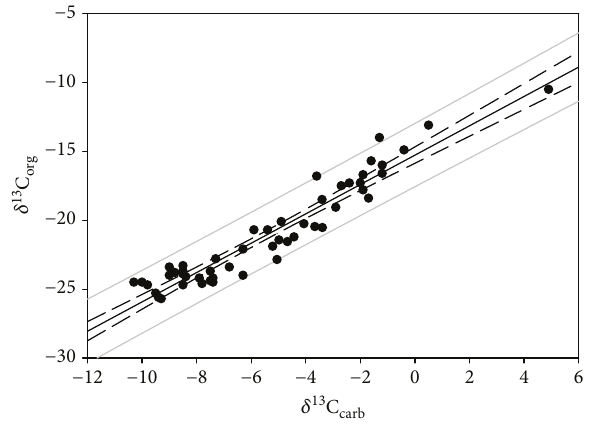
Figure 5: Plot of the relationship between δ 13 C and δ 13 C for carb org samples collected > 30 cm below the soil surface. The results from di ff erent regions and di ff erent climatic regimes all fall along the same regression line and the calculated Δ 13 C values closely matches the theoretical value given in equation (1). While δ 13 C org actually drives δ 13 C , by convention Δ 13 C is δ 13 C - δ 13 C , carb carb org so that is how the data have been regressed here. The solid black line represents the linear regression, the dashed lines the 95% con fi dence interval, and the grey lines the 95% prediction con fi dence interval.